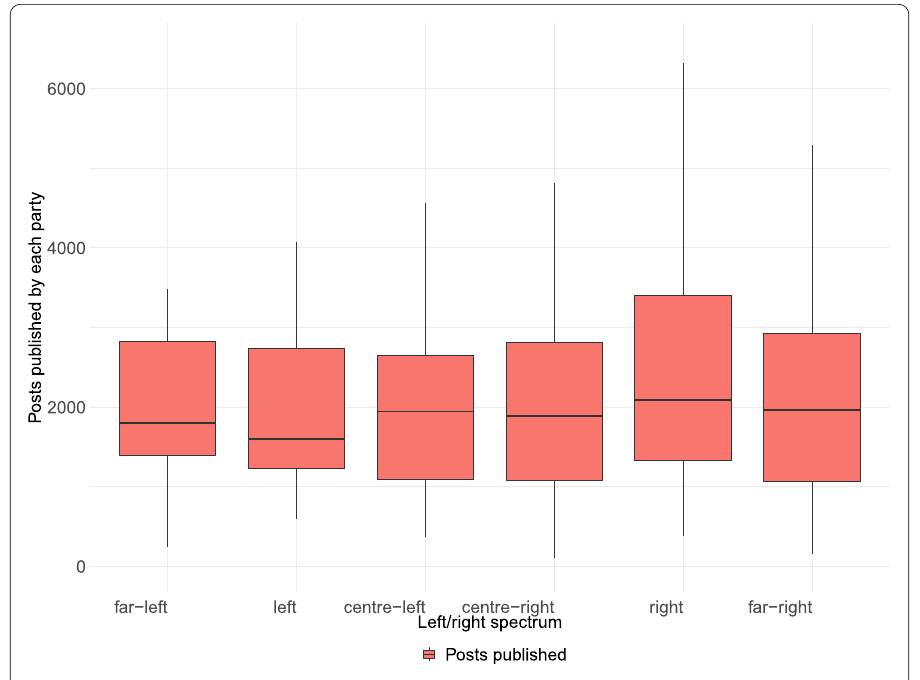
Figure 4 Boxplot of posts published by each party, divided by ideology. The ideology is divided in the left-right scale using the following intervals: far-left 0 < 1.5, left 1.5 < 3.5 centre-left 3.5 < 5, centre-right 5 < 6.5, right 6.5 < 8.5, far-right 8.5 <